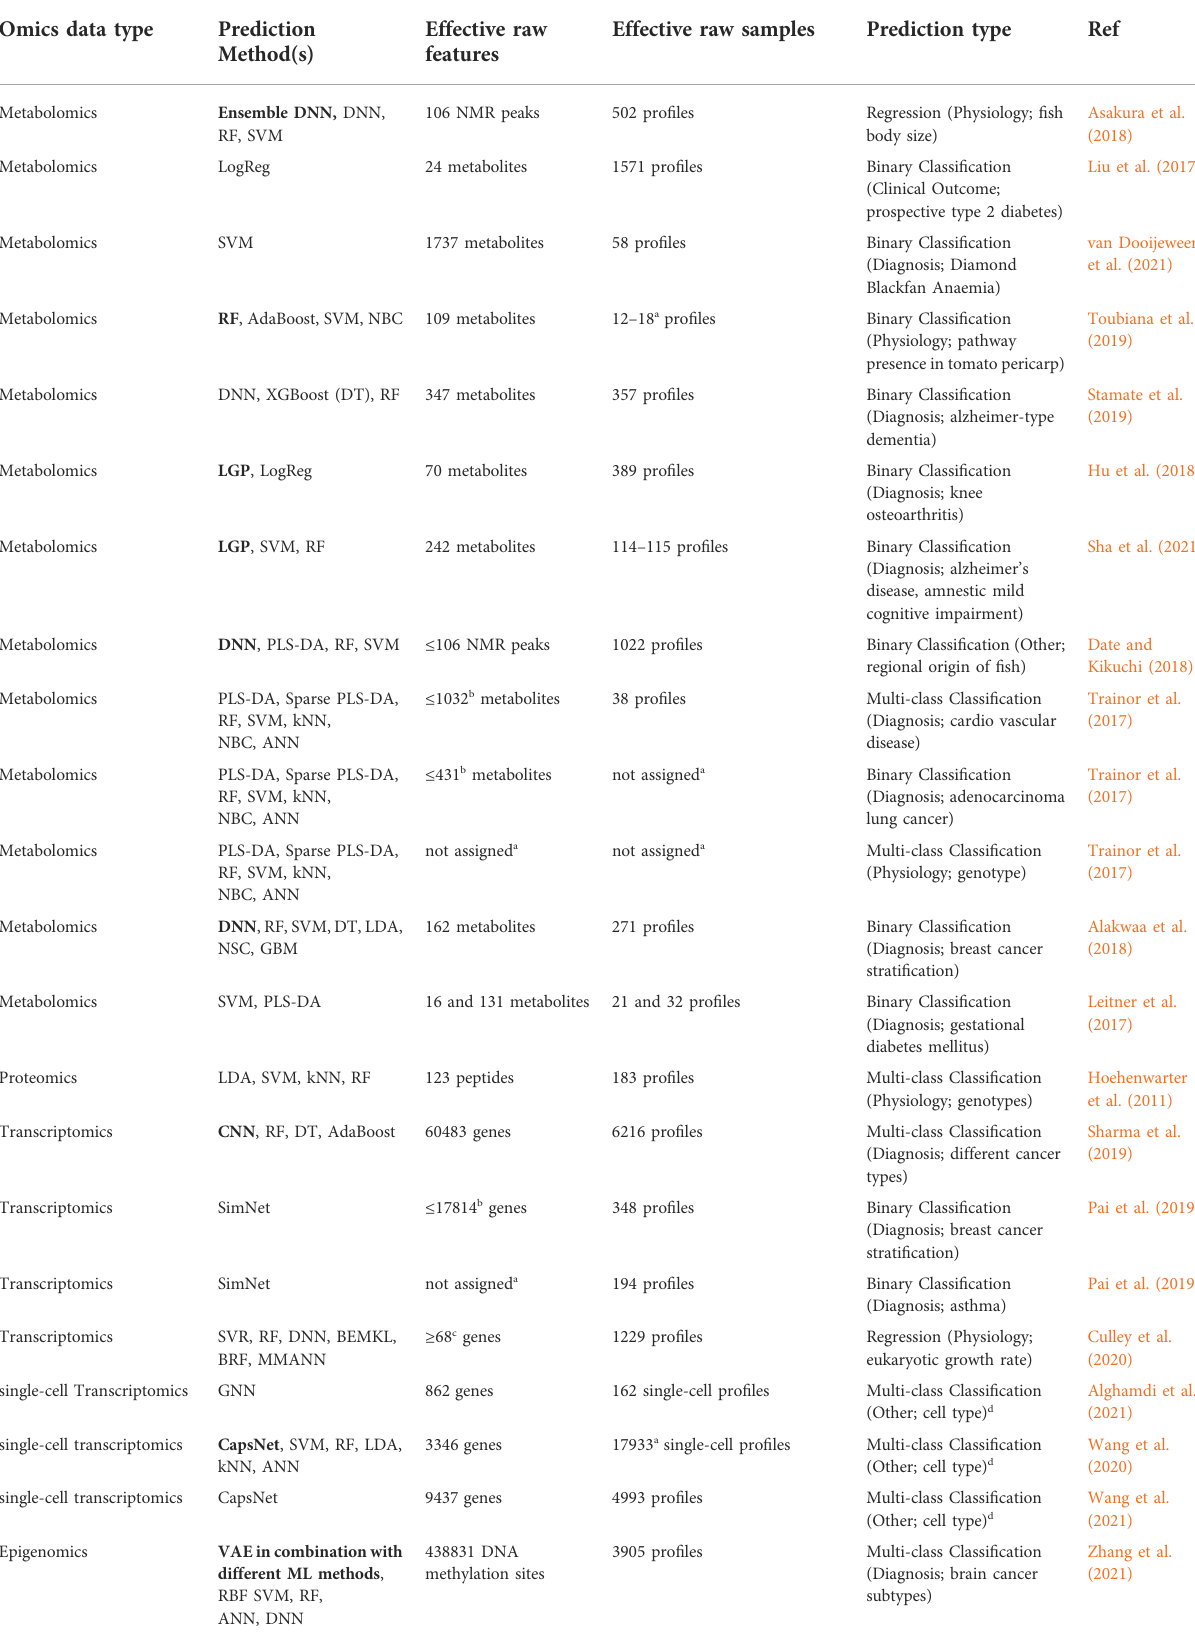
TABLE 1 Overview of the categorized